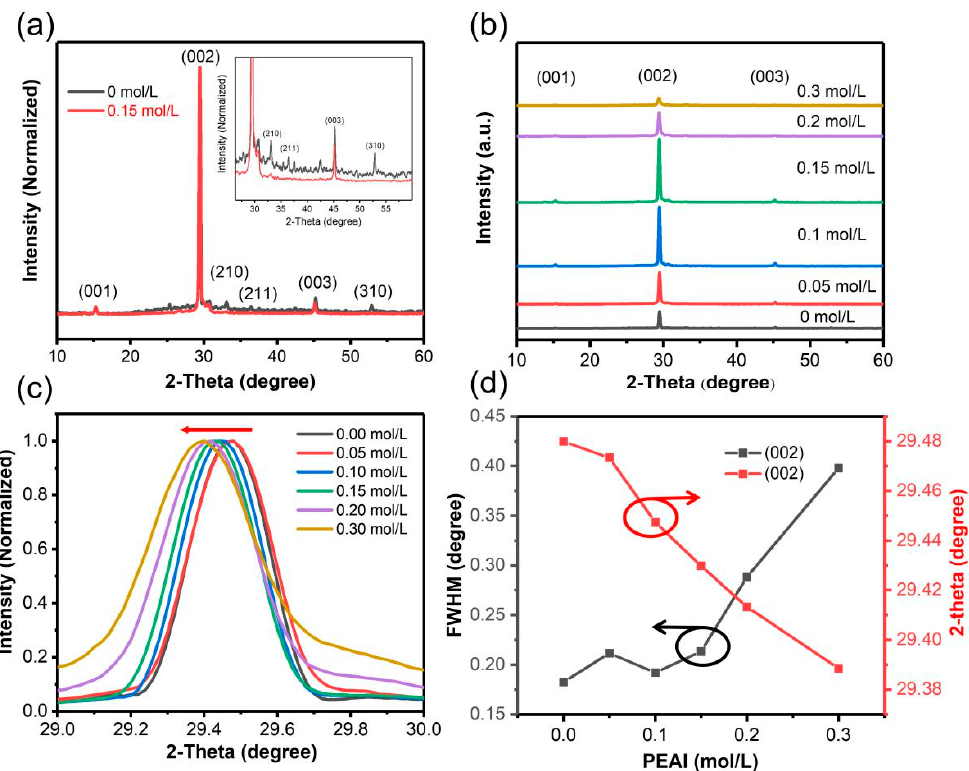
Figure 3. ( a ) XRD patterns of perovskite with and without PEAI. ( b ) XRD patterns of perovskite with various PEAI concentrations. ( c ) Normalized XRD spectra of (002) diffraction peaks according to PEAI concentration. ( d ) Full-width at half-maximum (FWHM) and intensity variation of (002) XRD diffraction peaks.